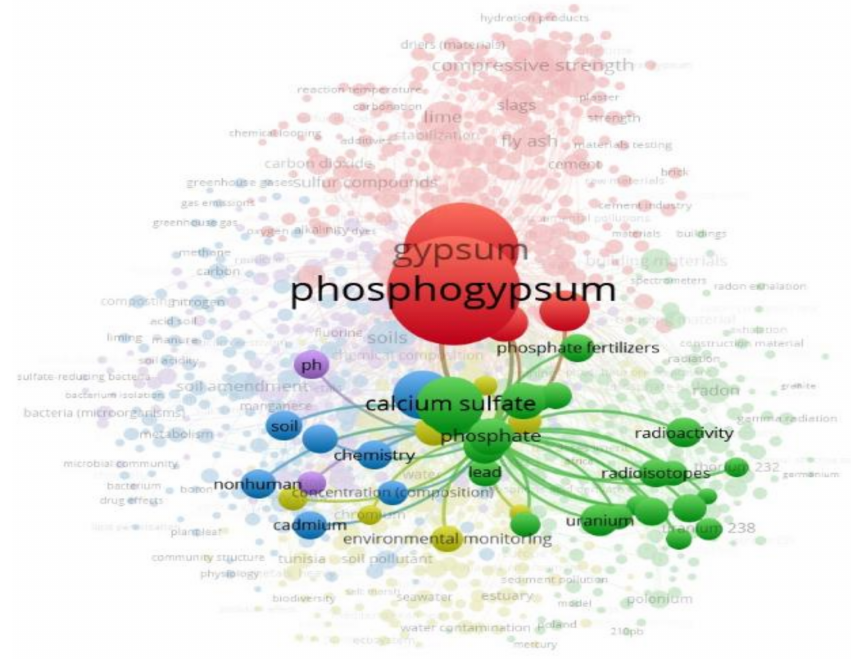
Figure 6. The fragment of overlay visualization ( с onstructed via VOSViewer v.1.6.15).